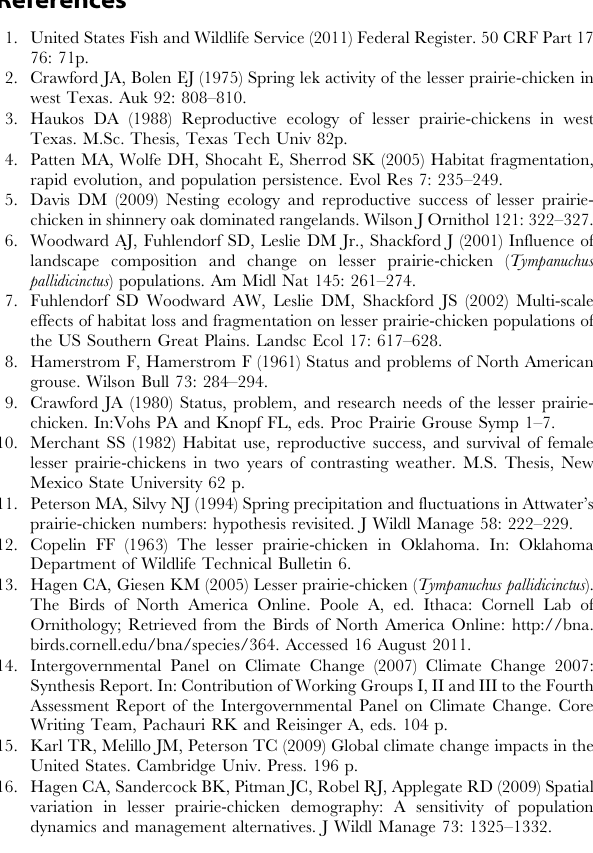
Table S2 Names and description of weather models developed to assess the effects of seasonal weather Table S3 Detailed description of three greenhouse gas emission scenarios used to obtain predicted values of climatic